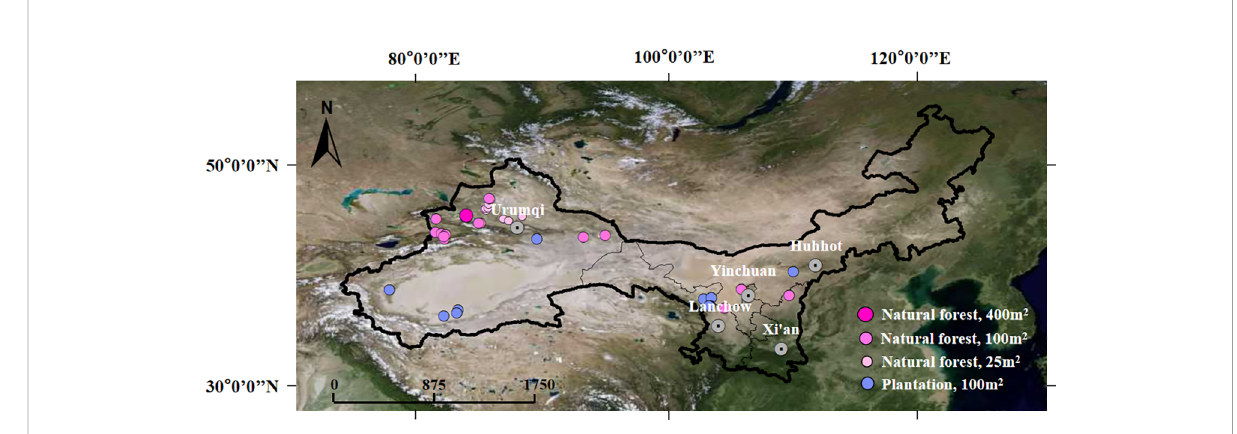
FIGURE 2 Sampling plot locations in the northwest arid region of